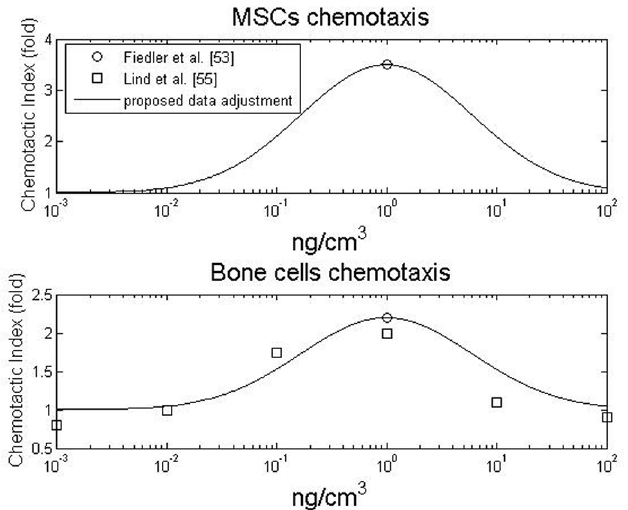
Fig 2. Influence of BMP-2 concentration on MSC (top) and bone cells (bottom) chemotaxis. Chemotaxis is expressed as a fold increase relative to cell migration without BMP-2